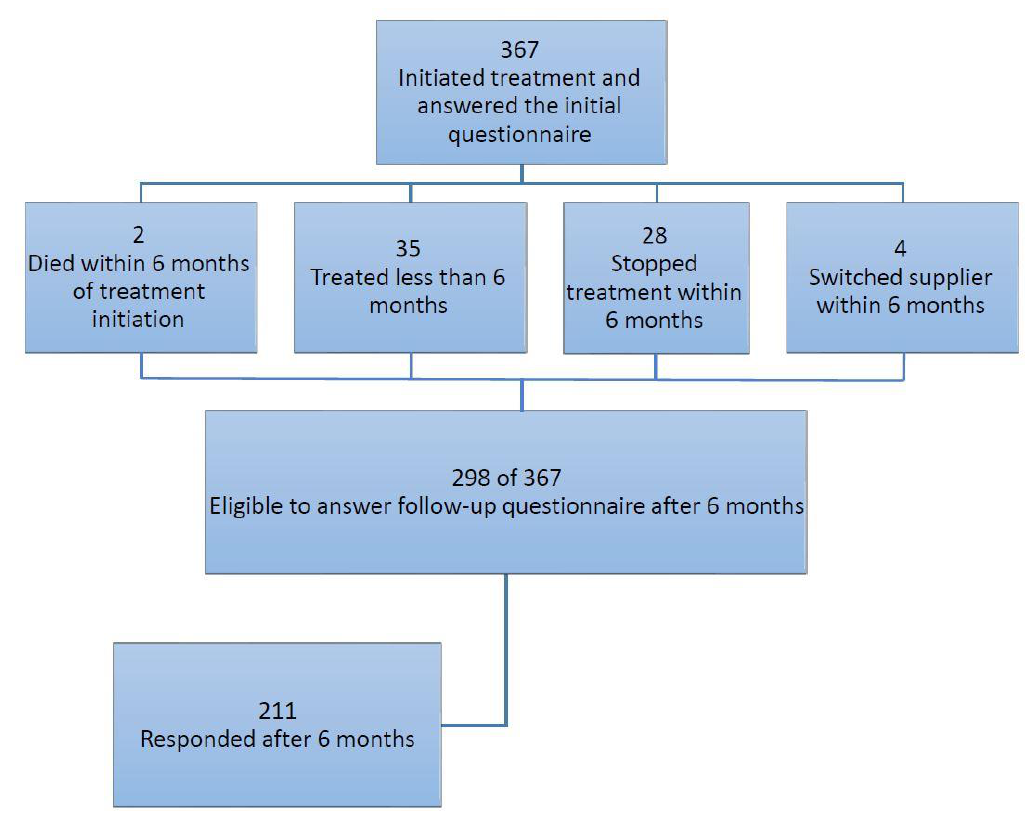
Figure 1. Flow chart of the study population.